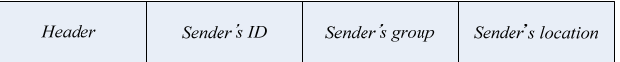
Figure 3. Frame format of HELLO packet in